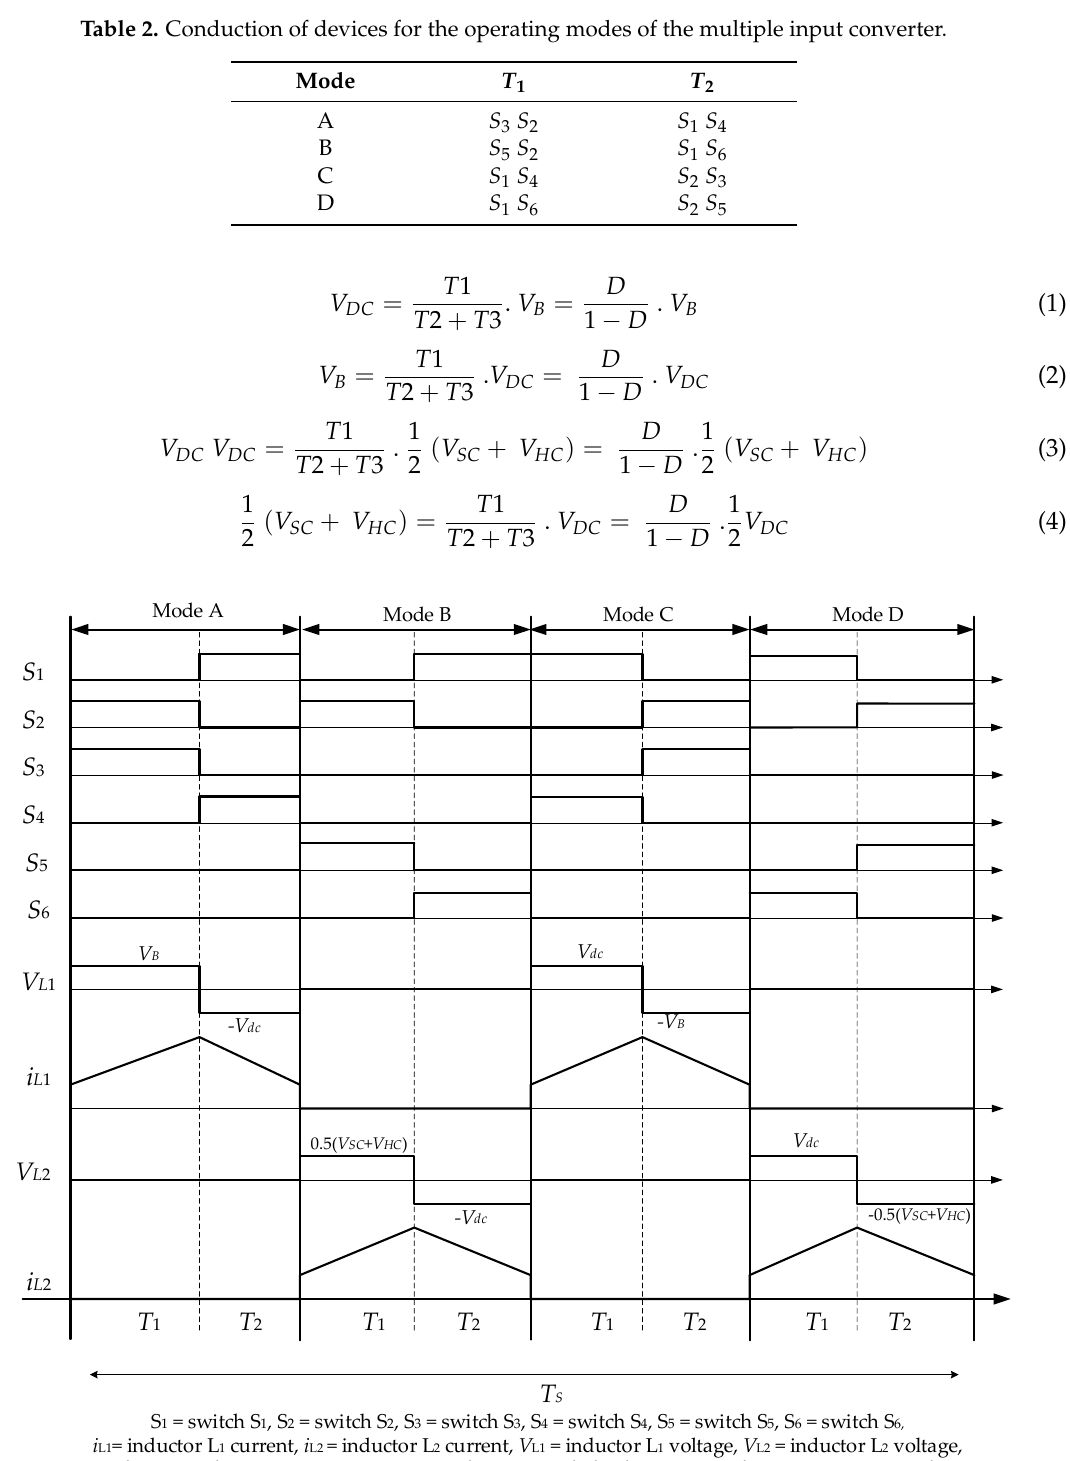
Figure 5. Steady-state waveforms of the operation of the multiple input converter for the proposed energy storage hybridisation topology.